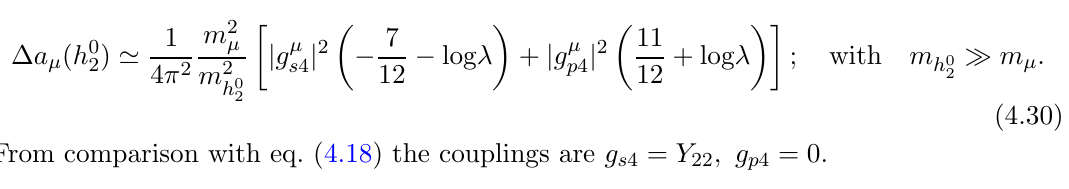
Figure 5(a): contribution due to CP-odd scalar, (cid:30) 0